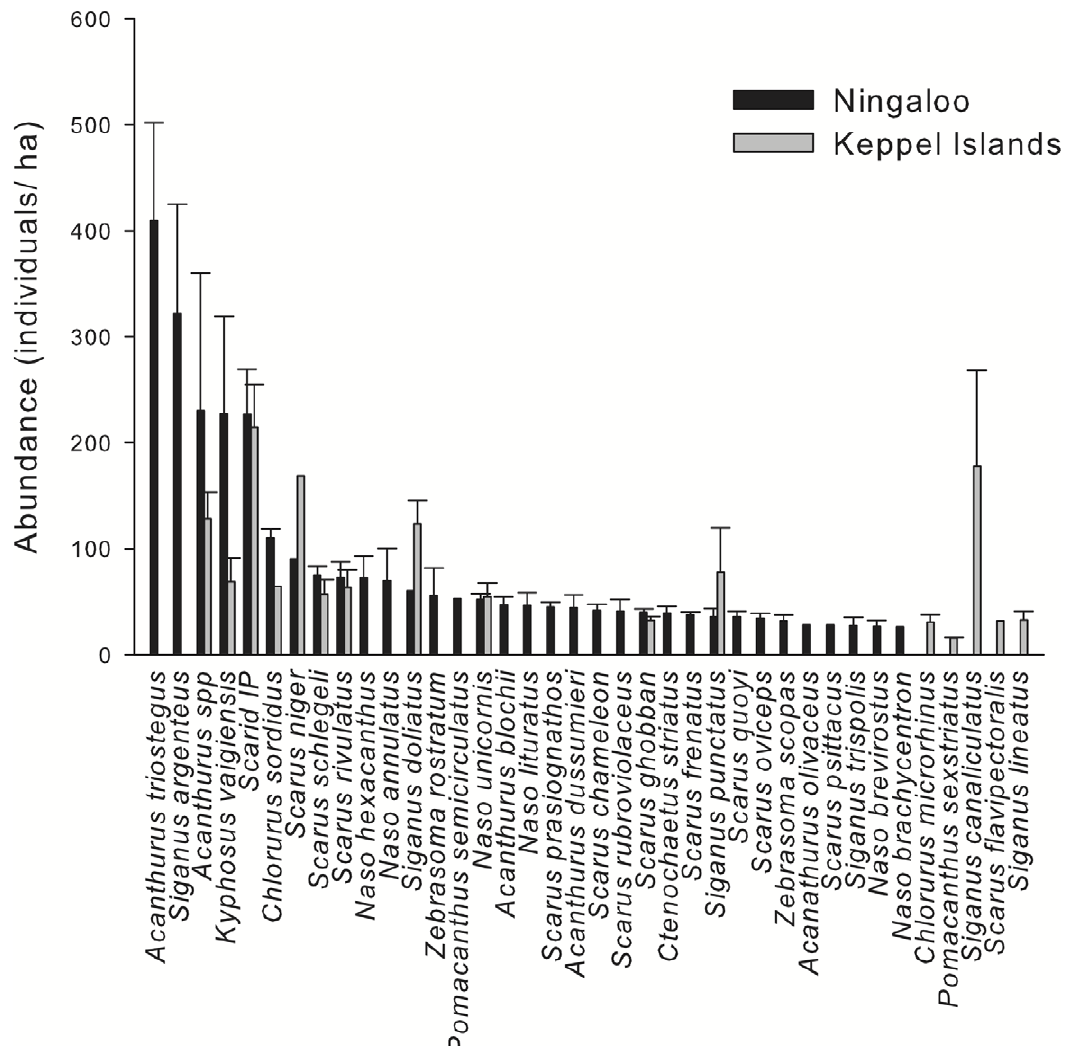
Figure 4. Abundance of herbivorous fish species surveyed using underwater visual censuses at each region (n=6). doi:10.1371/journal.pone.0045543.g004 PLOS ONE |